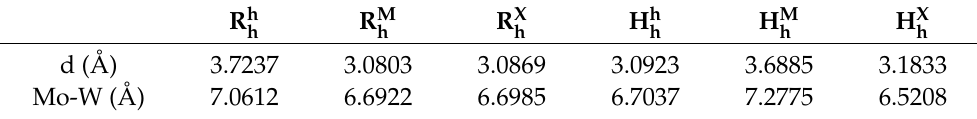
Table 1. Interlayer distance, d, and effective Mo-W distance for the studied R- and H-type